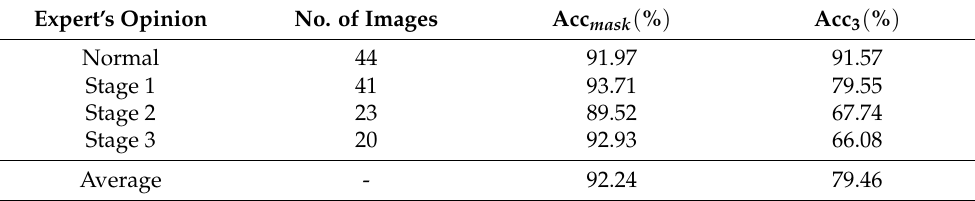
Table 6. Segmentation performance on 128 images in the blind test set.